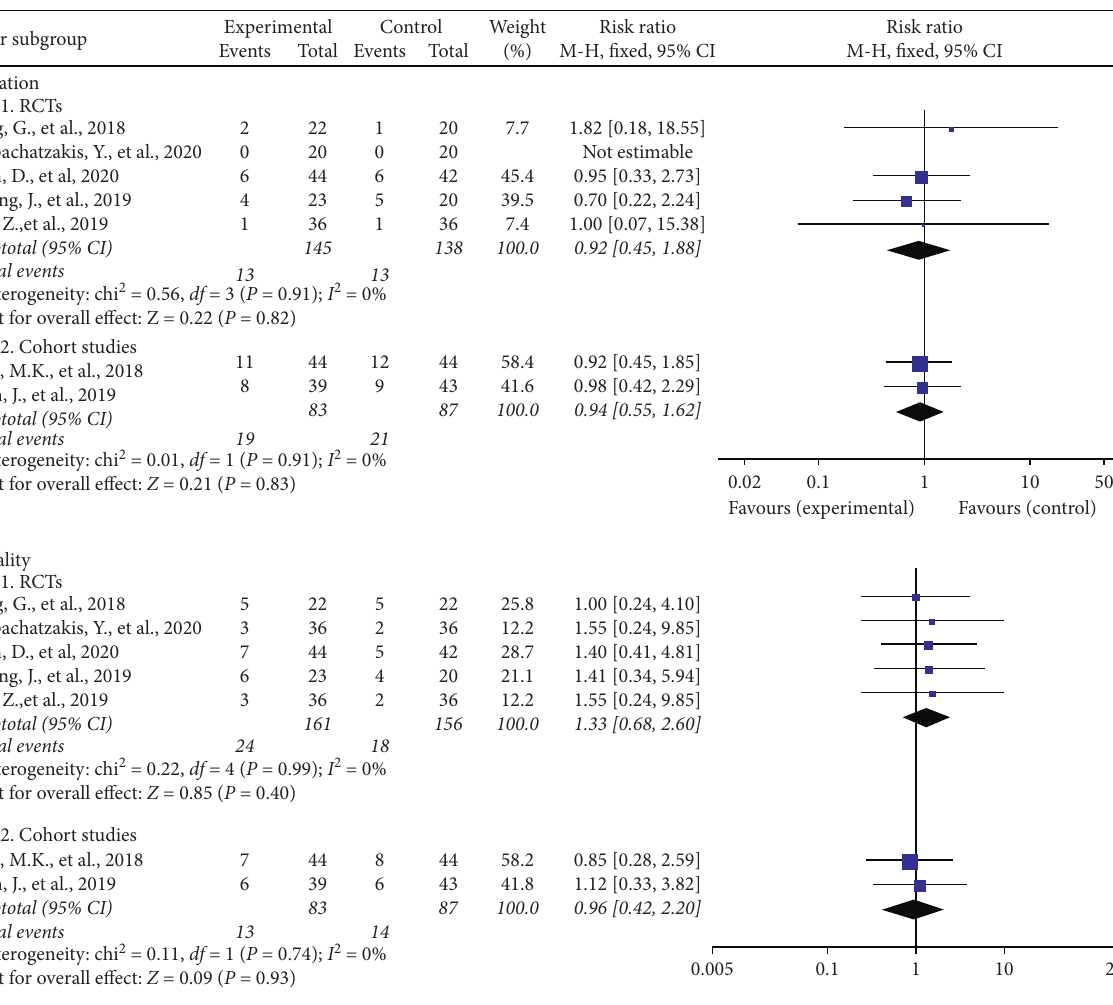
Figure 3: Intubation and